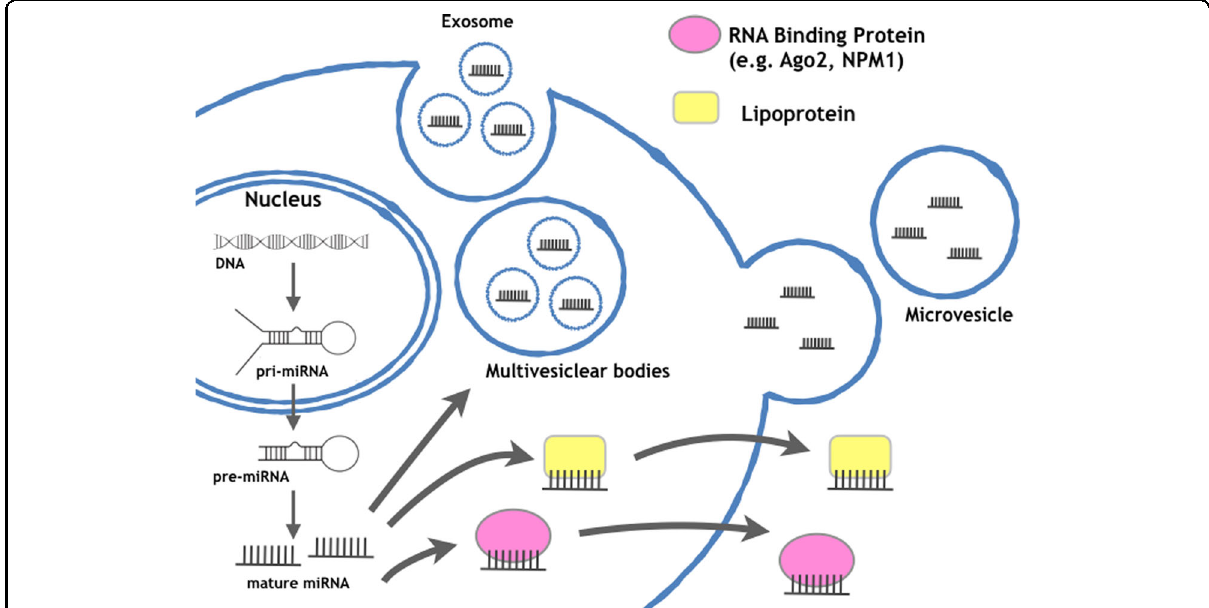
Fig. 4 Schematic representation of the current detection technology for biomolecules in EVs. Several methods exist for rapid, high- throughput analyses of EVs. In particular, current technology regarding RNA detection has been developing